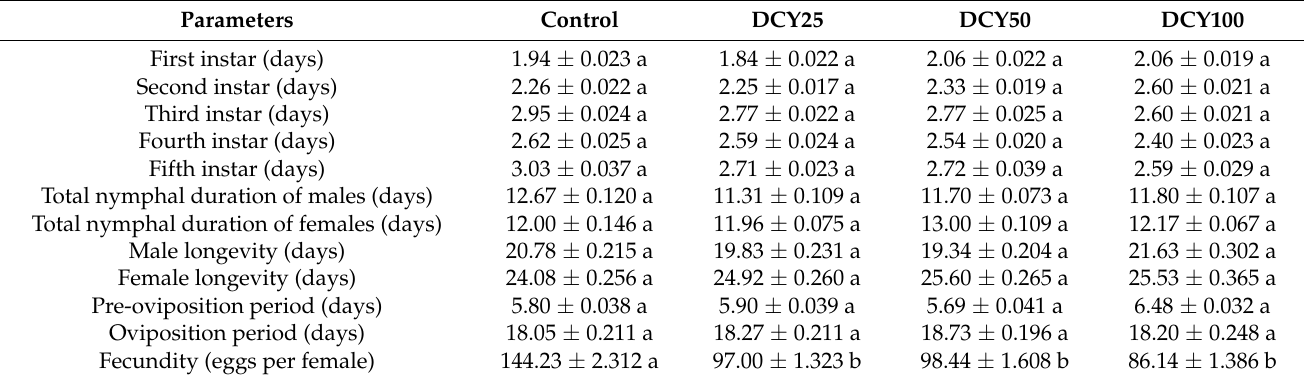
Table 1. Biological parameters of SBPH fed on rice under laboratory conditions.